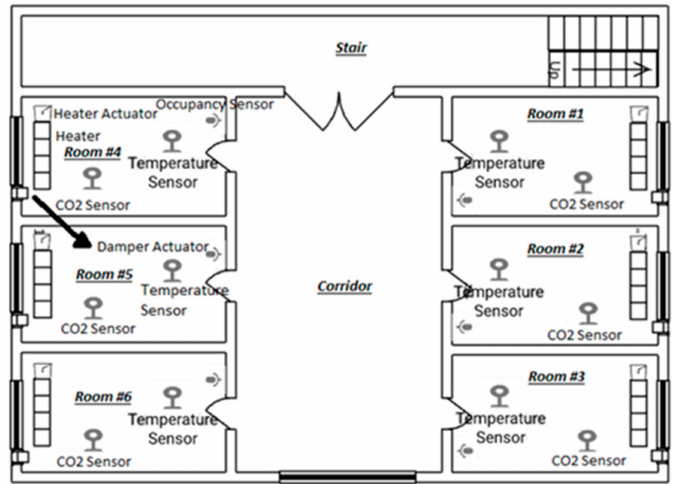
Figure 4. Office building sketch [34].